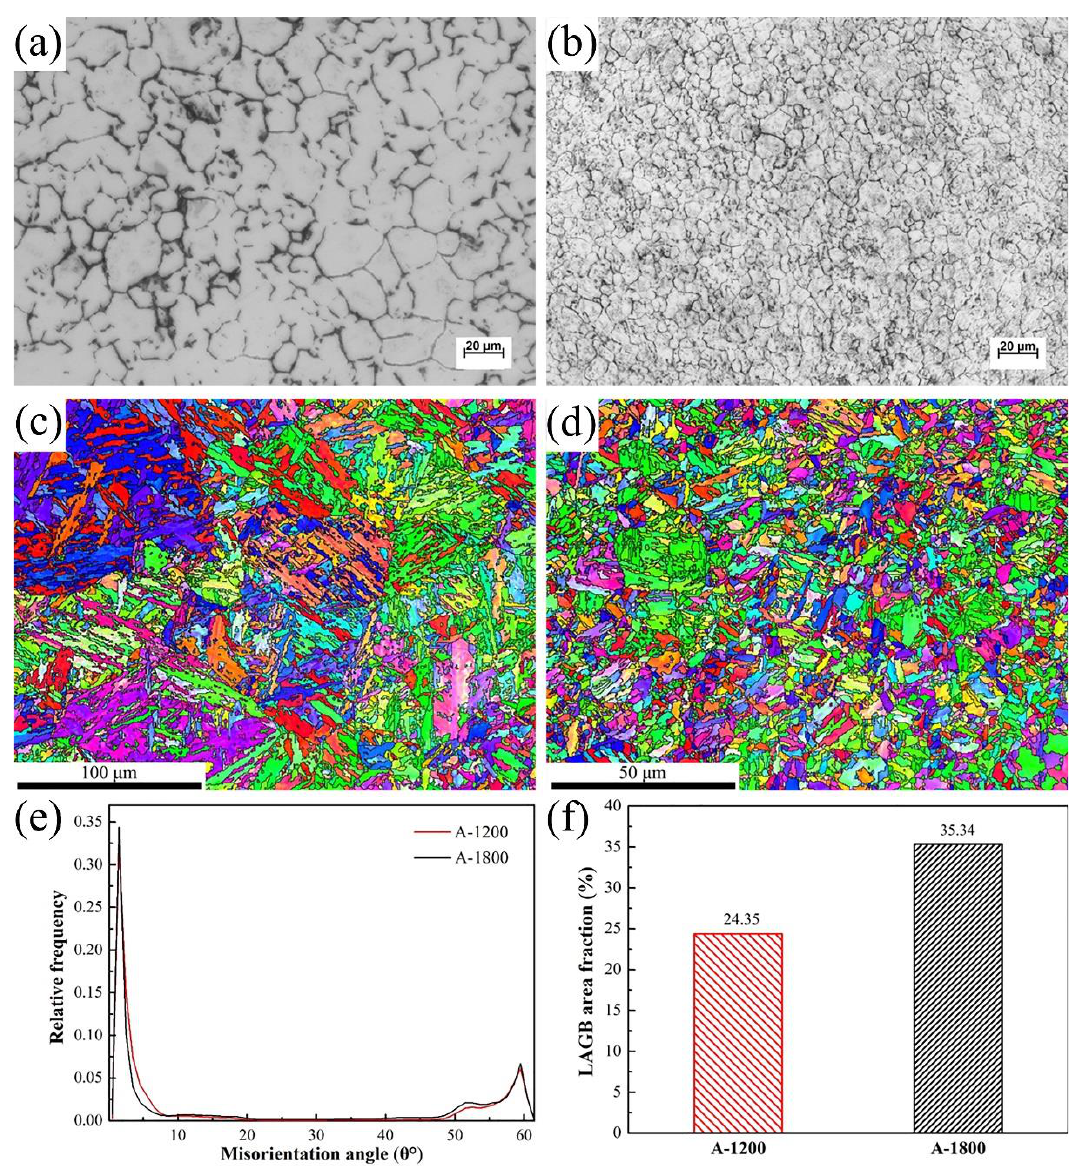
Figure 6. Locations of hydrogen accumulation in samples charged for 120 min: ( a ) A-1200 and ( b ) A-1800.